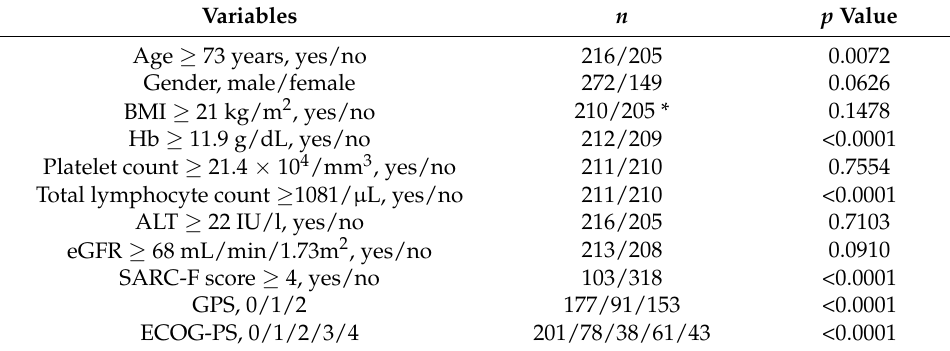
Table 2. Univariate analyses of factors linked to the overall survival.